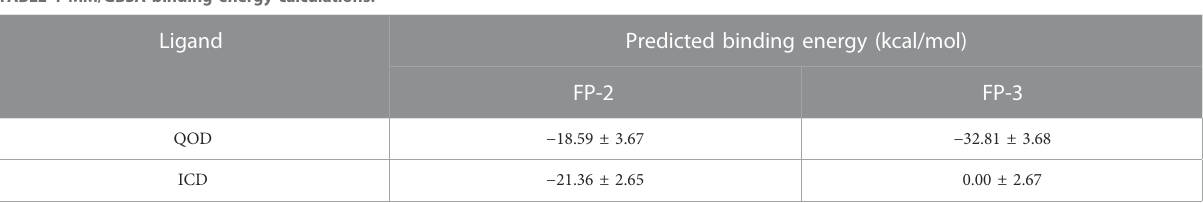
TABLE 1 MM/GBSA binding energy